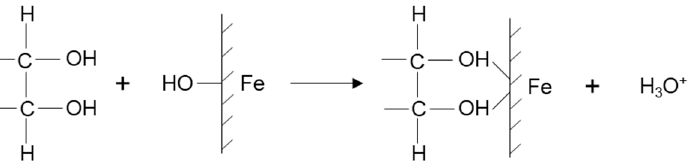
Figure 39. Schematization of dextrin interacting with the ferric oxyhydroxide sites of pyrite (adapted from Valdivieso et al. [135]).